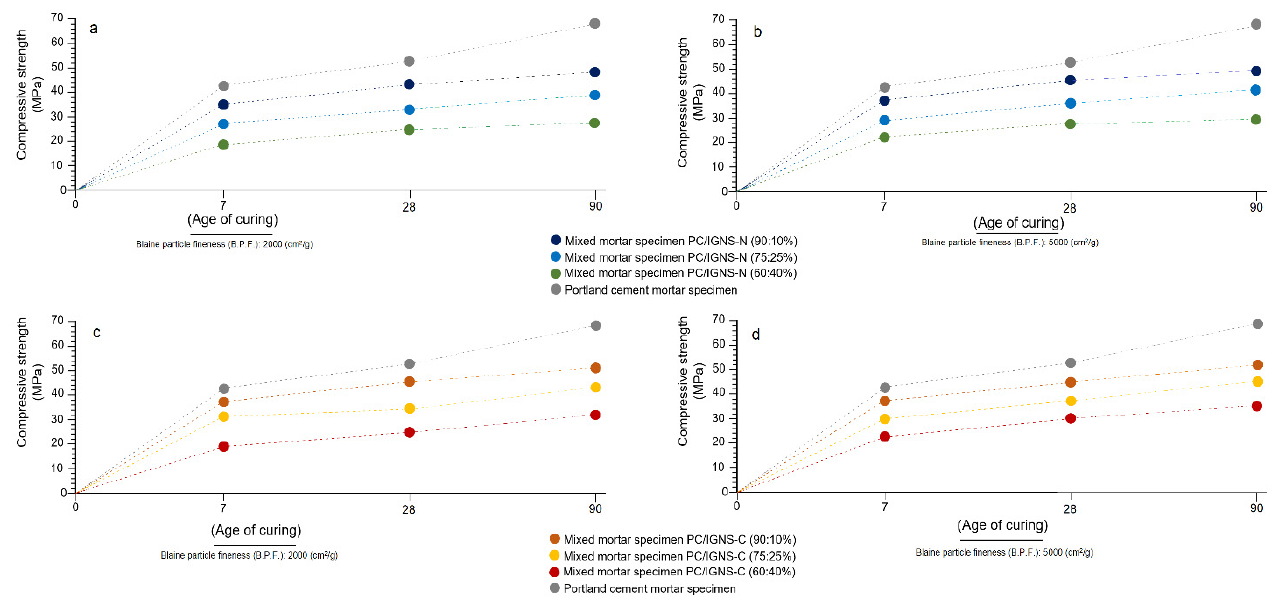
Figure 6. Mechanical compression strengths calculated from mortar specimens dosed with PC/IGNS and PCS at 7, 28 and 90 days. The ( a , b ) graphs represent the results obtained with the formulations of 10, 25 and 40% of natural IGNS and particle sizes of 2000 and 5000 cm 2 /g, respectively. A similar procedure is shown in ( c , d ), but with calcined samples.